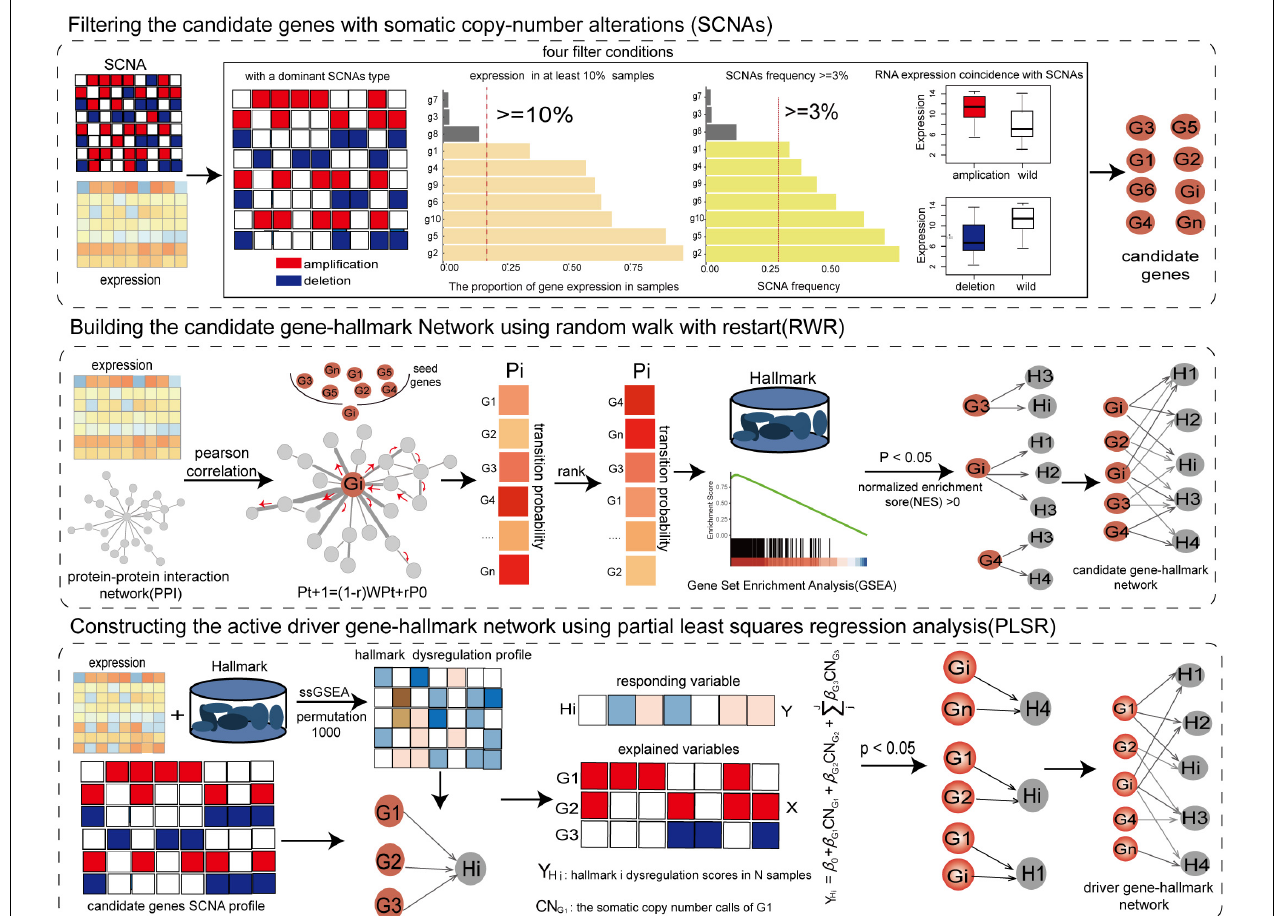
FIGURE 1 | The workflow of the integrative method for identifying SCNAs driving the dysregulation of cancer hallmarks.